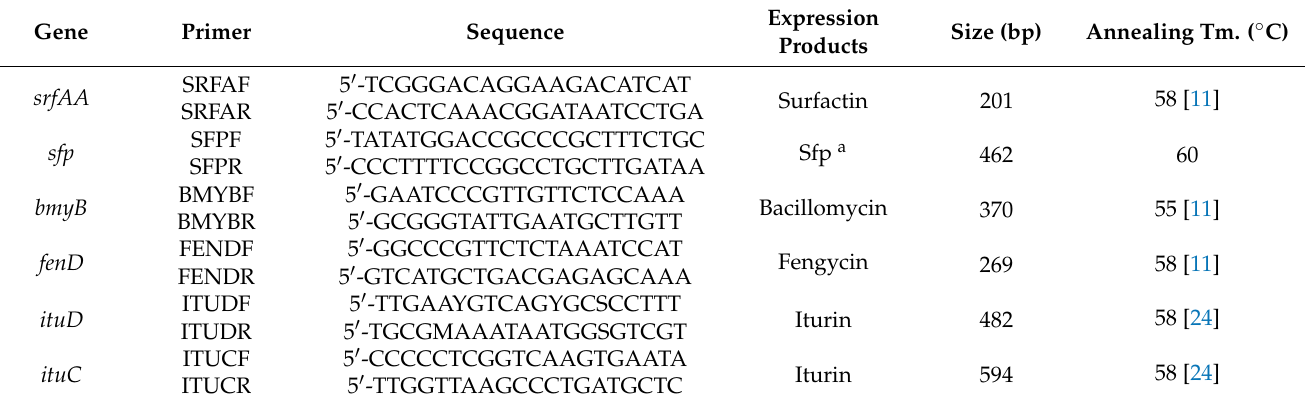
Table 1. Primers for PCR detection of LPs biosynthesis genes in B. amyloliquefaciens